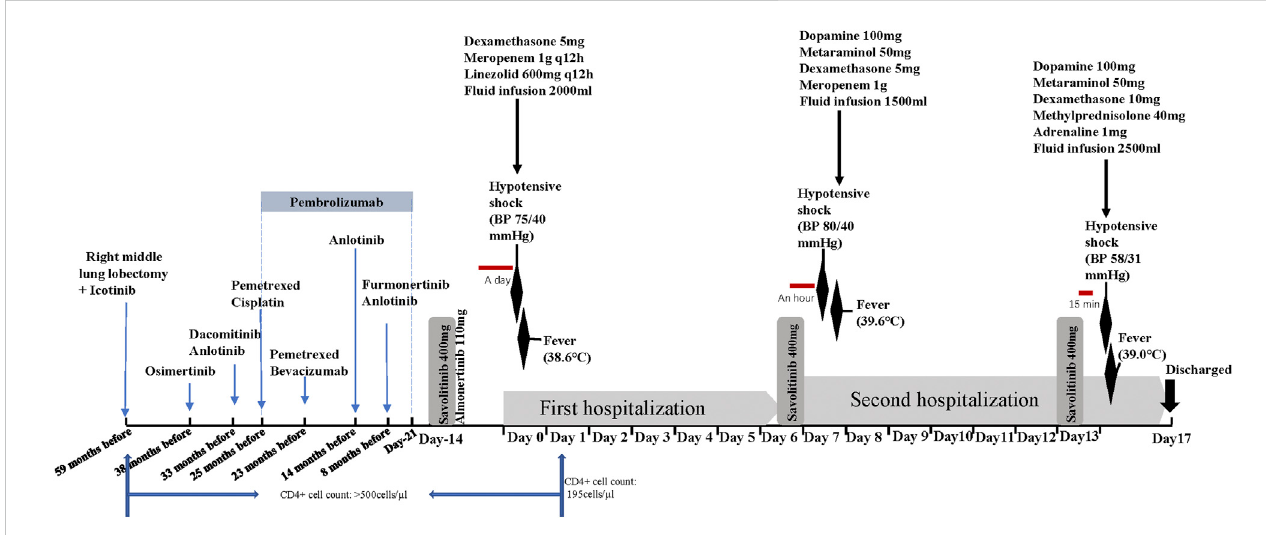
FIGURE 1 Treatment axis of the patient (time fl ows from left to right, day 0 is the time of the fi rst adverse reaction).